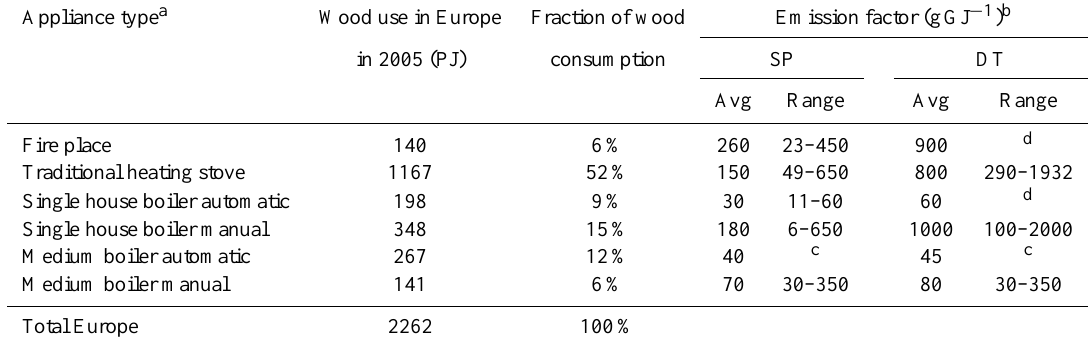
Table 2. Wood use by appliance type in Europe in 2005 and related solid particle (SP) and dilution tunnel (DT) particle emission factors. Appliance type